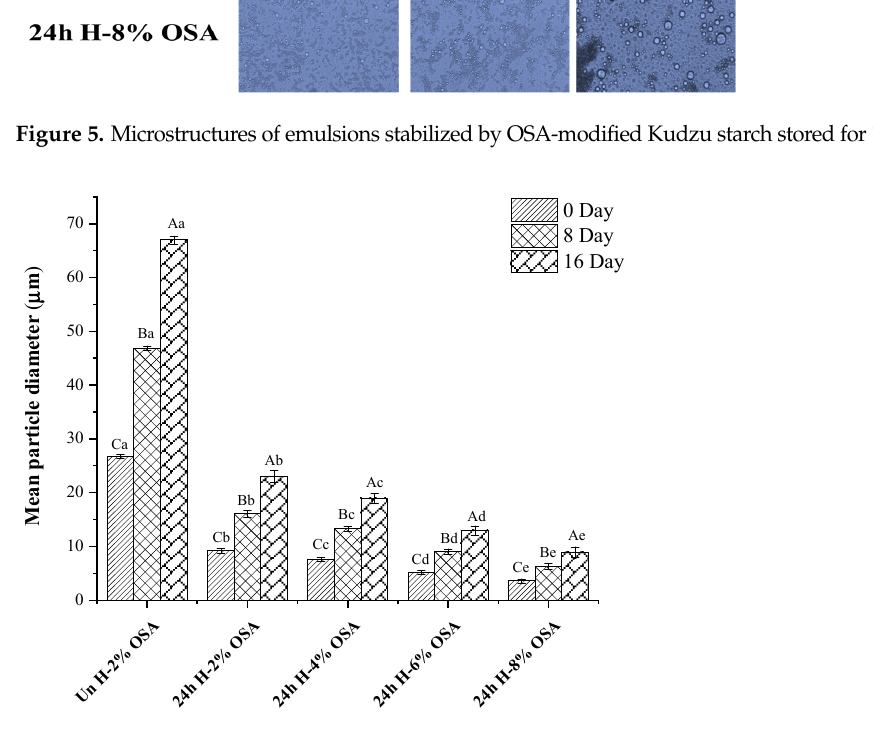
Figure 6. Mean droplet size of Pickering emulsions stabilized with OSA-modified PMS starches for the storage time of 0, 8, and 16 d. Samples shown with different capital letters (A, B, C) indicate a significant difference ( p < 0.05) when the same samples were compared for different storage times. Samples indicated with different lower-case letters (a, b, c, d, e) showed a significant difference ( p < 0.05) when the different samples were compared for the same storage time.